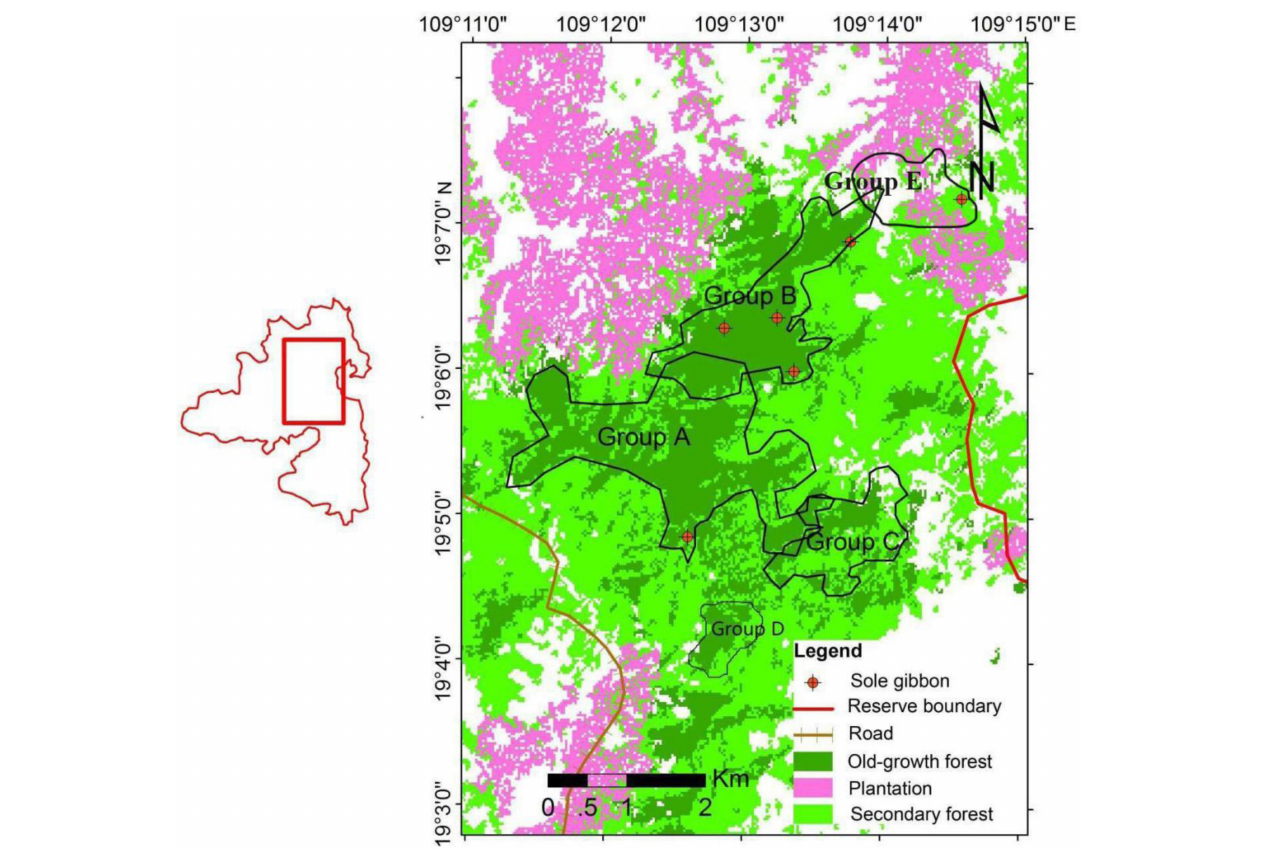
FIGURE 1 | Distribution of the five remaining groups of Hainan gibbons (Group E was discovered in June 2020; the survey of this study does not include Group E).